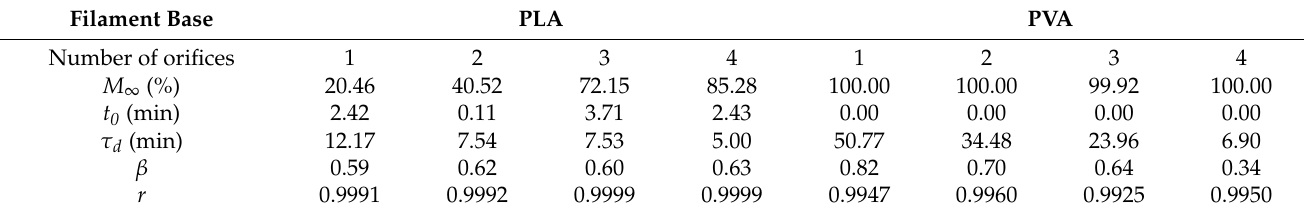
Table 3. Kinetic parameters of dissolution estimated according to Weibull distribution function (pH = 1.2). Filament Base PLA